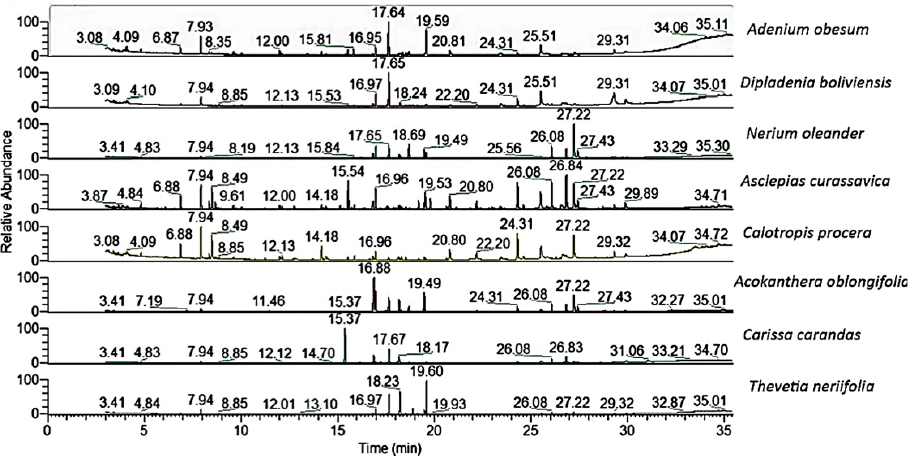
Figure 5. The GC-MS chromatograms of the chemical compounds of the studied Apocynaceae